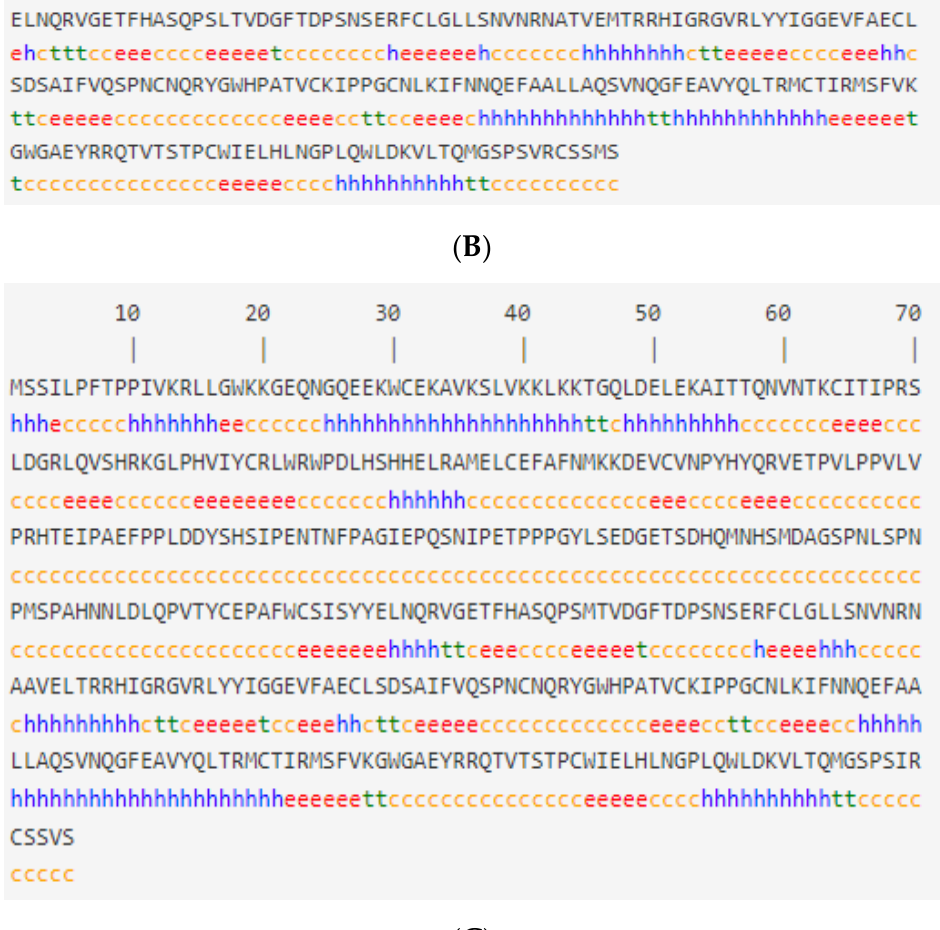
Figure 3. Protein secondary structure of SMAD1 ( A ), SMAD2 ( B ) and SMAD3 ( C ) in Tibetan sheep. The α helix is in blue, the β turn is in green, the random coil is in yellow, and the extended strand is in red.